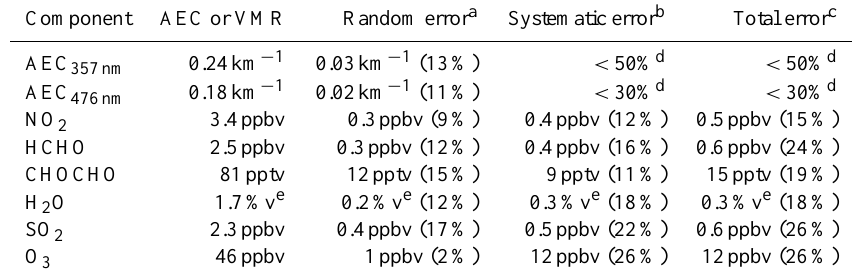
Table 2. Median values of retrieved quantities (AECs and VMRs in the 0–1km layer) and estimated errors for the CINDI campaign period. Component